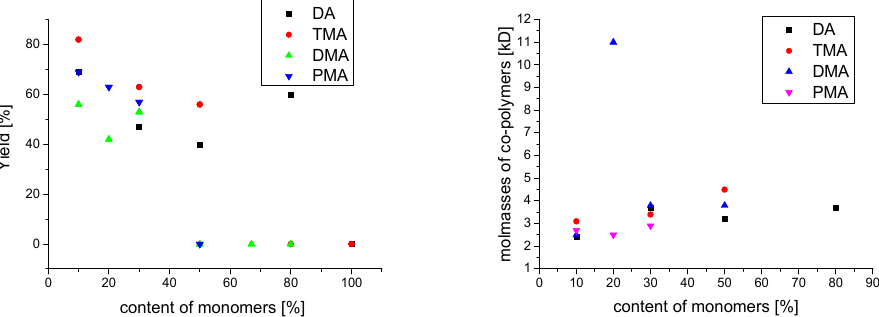
Figure 4. Dependencies of the yield of the corresponding copolymers ( left ) and M n (average molecular weights) of the copolymers on the monomer composition in mol percentage ( right ).